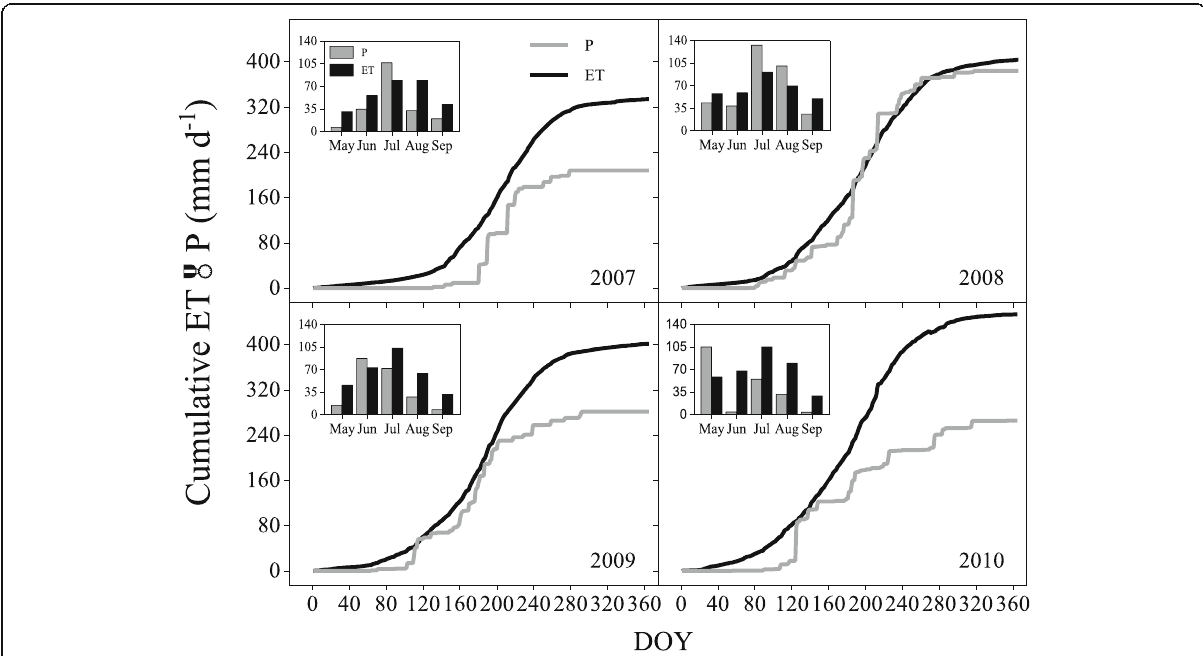
Fig. 7 The annual and monthly accumulation of precipitation ( P ) (gray) and evapotranspiration (ET) (black) for the Songnen meadow steppe during 2007 – 2010